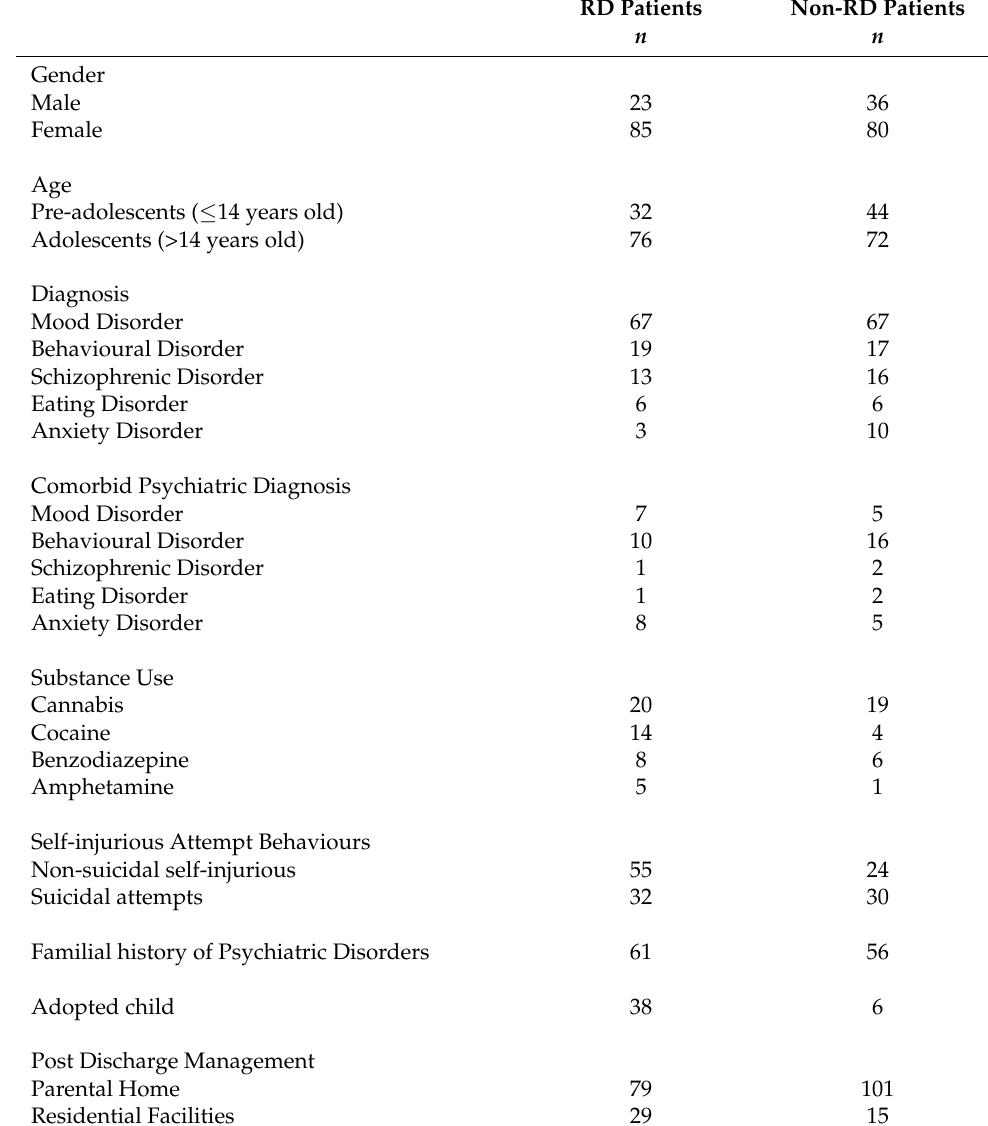
Table 1. Demographic information of Revolving Door and non-Revolving Door